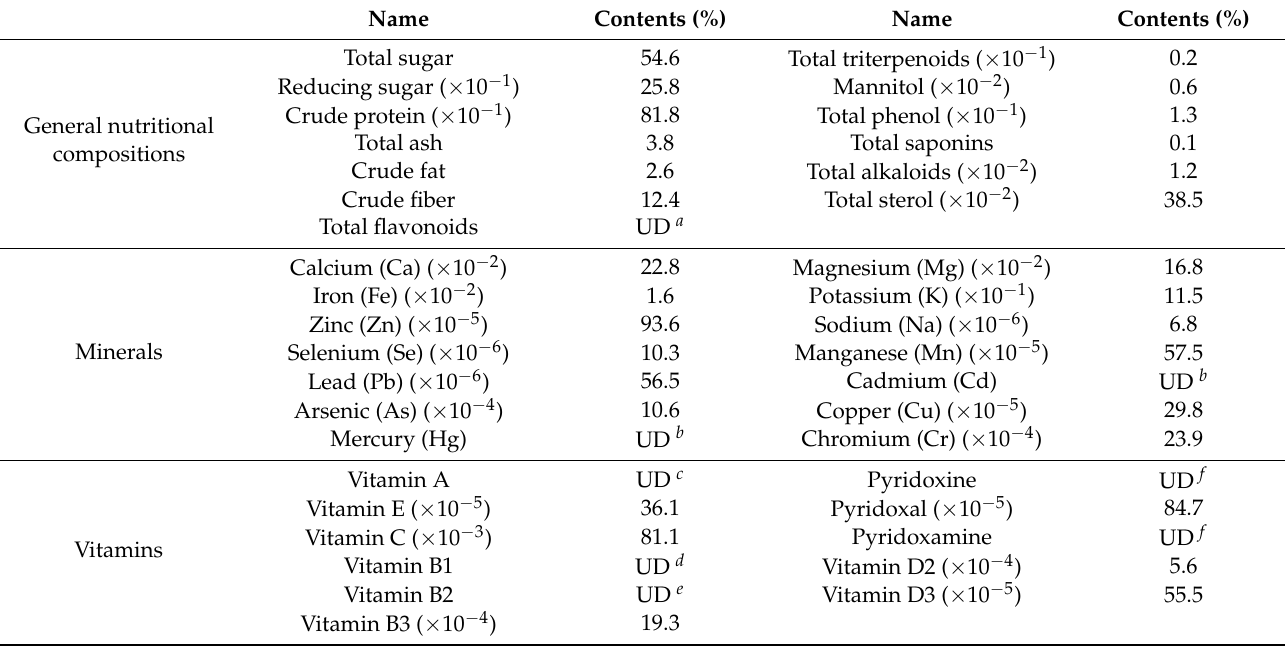
(Table 1). Total flavonoids and vitamins A, B1, B2, pyridoxine, and pyridoxamine were not detected (Table 1). Hg and Cd were not detected among the 14 minerals analyzed (Table 1). Table 1. The main components of